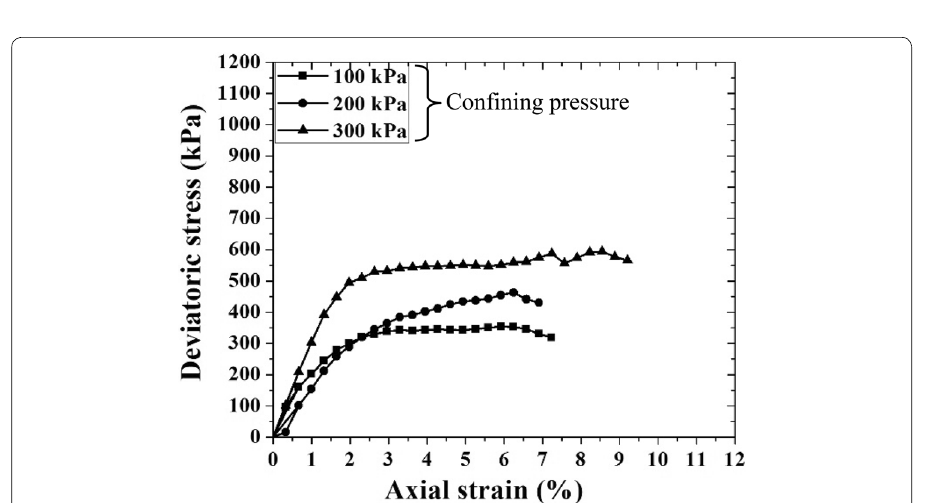
Fig. 29 Stress strain behavior of Borabanda MSW at